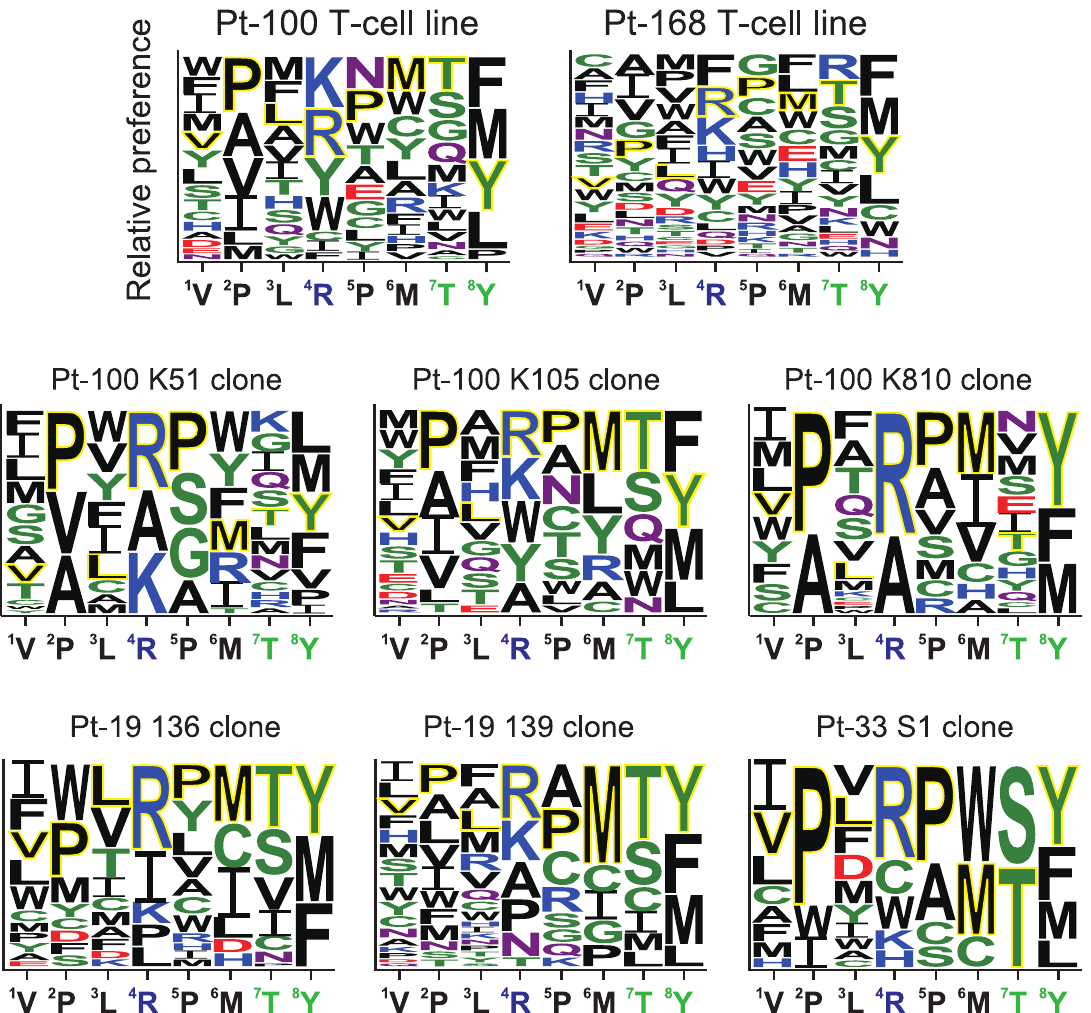
Figure 1. Amino acid residues preferentially recognized by VY8-specific CD8 + T cells. Graphical representation showing relative preference for amino acid residues recognized by VY8-specific T cell lines and clones based on the CPL scan data shown in Figure S1. Responses . 20% were included. A web-based application, WebLogo 3 (http://weblogo.threeplusone.com/), was used to generate the graphic. Colours represent physicochemical properties: polar (G, S, T, Y and C), green; neutral (Q and N), purple; basic (K, R and H), blue; acidic (D and E), red; hydrophobic (A, V, L, I, P, W, F and M), black. The index residues at each position are outlined in yellow. Residue size is proportional to T cell recognition